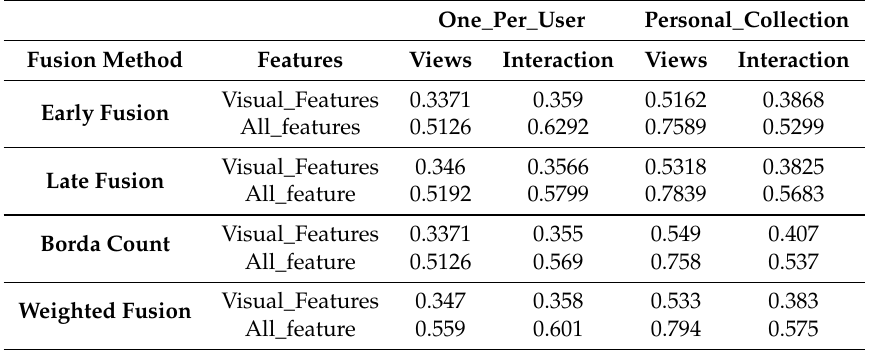
Table 8. Performance of fusion techniques in the prediction of images